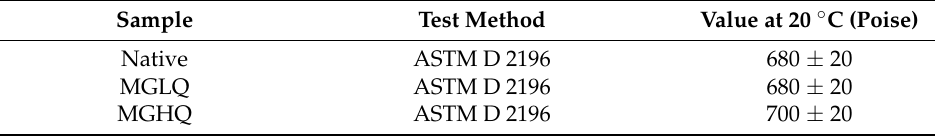
Table 3. Viscosity measurement of the bitumen emulsion samples.